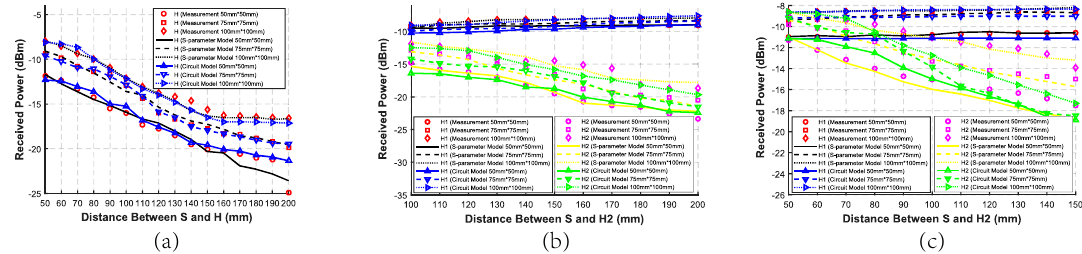
Figure 13. Measurement, simulated S-parameter model, and circuit model received power of two harvesters with different areas of the ground electrodes, including 50mm × 50mm, 75mm × 75mm and 100mm × 100mm, and different distances where the forward and backward distances remain the same. ( a ) Case III-1: the SSSH case with three different areas of the ground electrodes. ( b ) Case III-2: the SSMH-SA case with three different areas of the ground electrodes. ( c ) Case III-3: the SSMH-OP case with three different areas of the ground